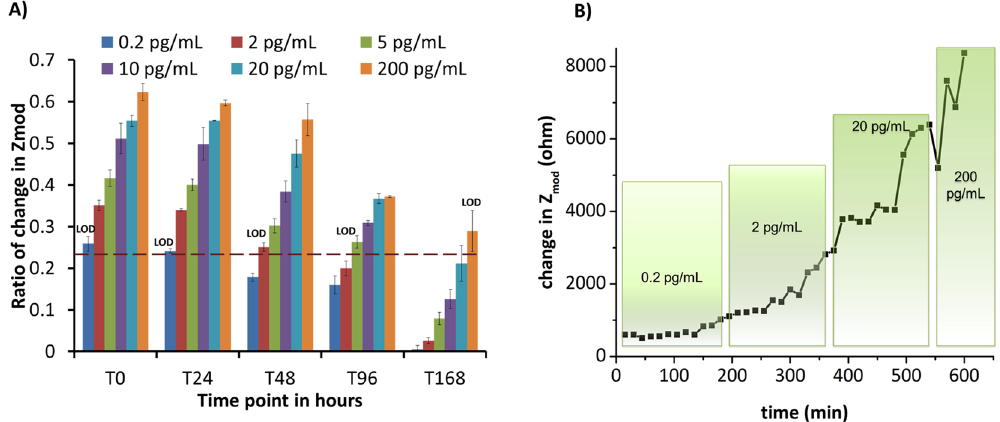
Figure 7. ( A ) Percent change in Zmod ratio of antigen IL-6 concentration varying from 0.2 pg/mL to 200 pg/ mL tested for varying storage time of antibody IL-6 for time T 0 , T 24 , T 48 , T 96 and T 168 at 4 °C. The dashed line represents specific signal threshold (SST). ( B ) Continuous time based detection of IL-6 in human sweat through impedance